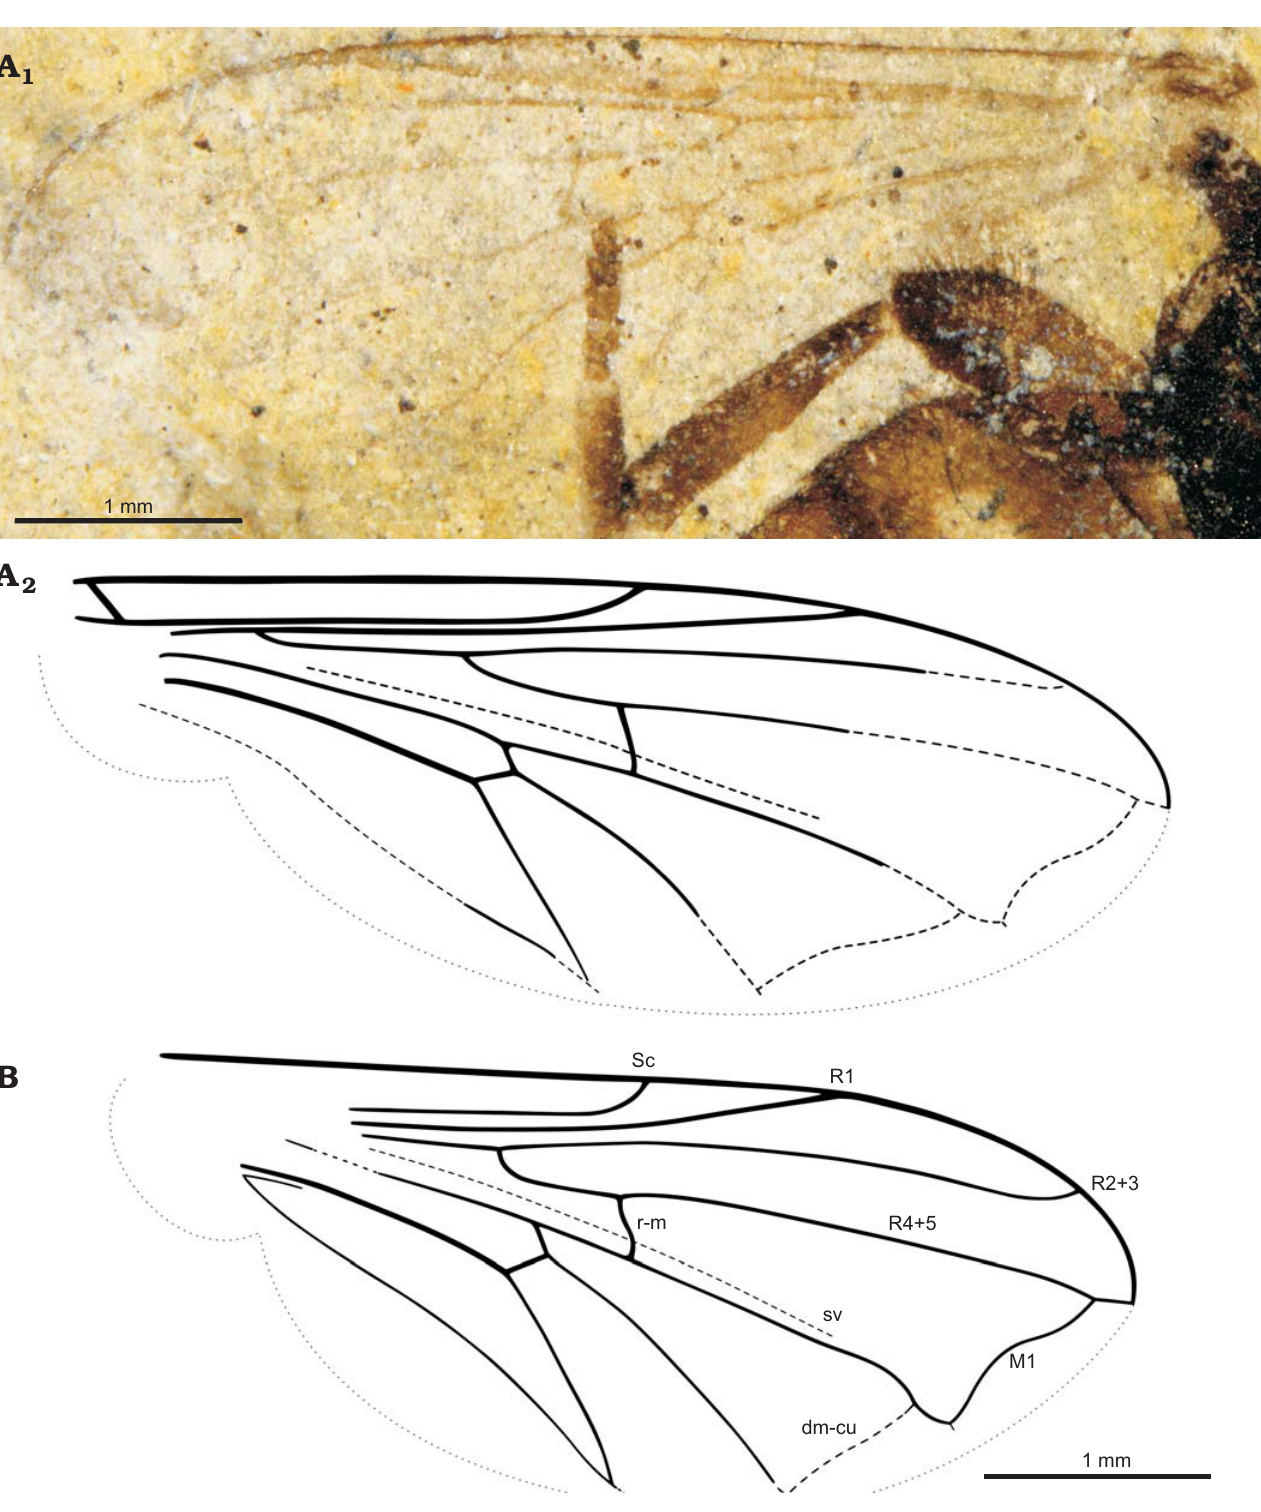
Fig. 2. Pipizine hoverfly Oligopipiza quadriguttata Nidergras, Hadrava, and Nel gen. et sp. nov., Rupelian, Céreste, France. Wing venations. A . Holotype RNGL-S01, normal light photograph (A 1 ), reconstruction (A 2 ). B . Allotype RNGL-S10, reconstruction. Abbreviations: dm-cu, distal median-cubital crossvein; M1, first branch of median vein; R1, R2+3, R4+5, branches of radius; r-m, radial median crossvein; Sc, subcostal vein; sv, supplementary